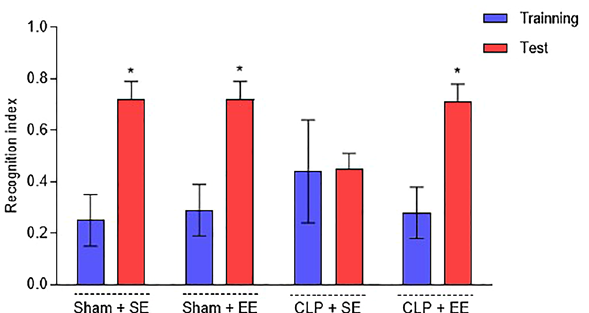
Figure 8. Object recognition task after the environmental enrichment protocol in animals submitted to sepsis. The recognition index is presented as median and interquartile ranges. Differences between training and testing were assessed using the Mann–Whitney U test followed by the Wilcoxon test. nº = 10 each group. * p < 0.05 when comparing the test versus training of your own group. EE: environmental enrichment; SE: standard